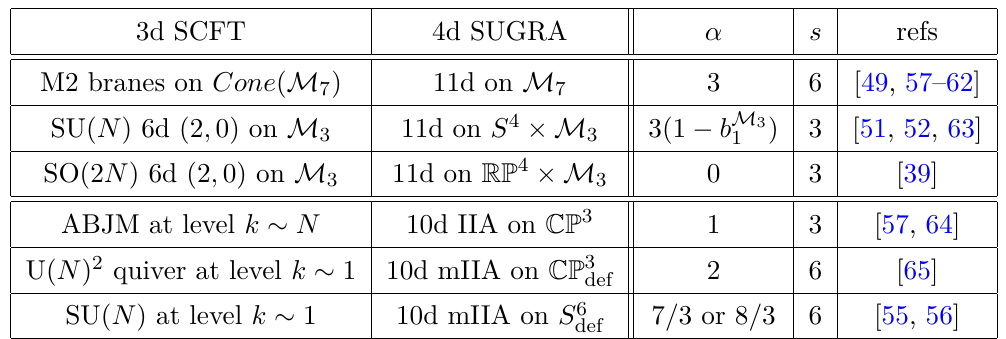
Table 2 . The constants α and s in (1.3) for several classes of 3d SCFTs and the corresponding supergravity compactifications to an effective 4d model, together with the appropriate references. The first entry covers a range of M2 brane theories including ABJM [66] along with other N = 3 and N = 4 quivers [67–69], and even a few examples where M preserving only N = 2 supersymmetry [57, 62,